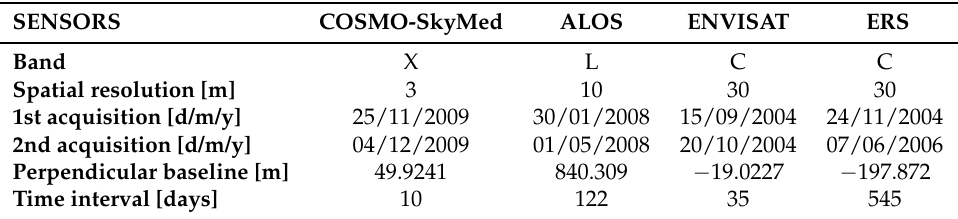
SENSORS Table 2. Synthetic Aperture Radar (SAR) interferometric data pairs of the Etna Volcano used for validation of